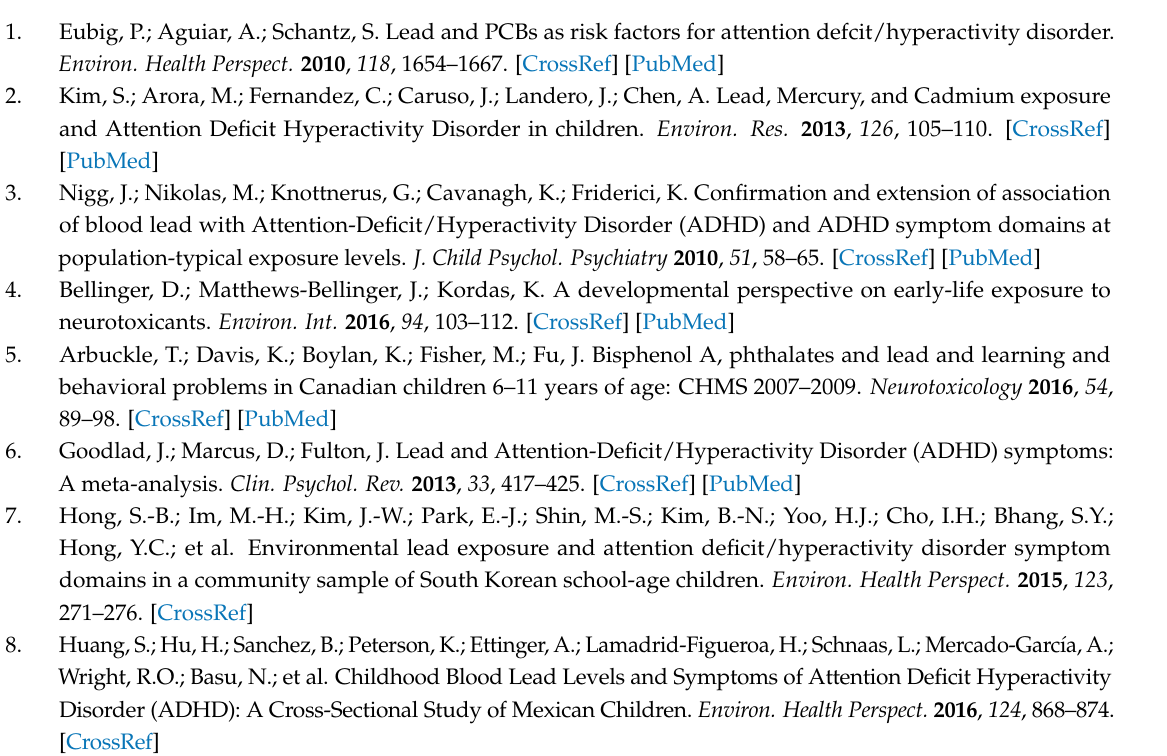
s1. Table S1: Percent of children with behavioral problems (T score ≥ 65 or ≥ 70) stratified by gender. Table S2: Patterns of missing values in study variables. Table S3: Association between blood lead concentrations and ( n = 353). Table S4: Covariate-adjusted association between blood lead concentrations and teacher ratings of Table S5: Association between blood lead among 5–8-year-old children with blood lead concentrations <5 and ≥ 5 µ g/dL using an imputed dataset ( n =